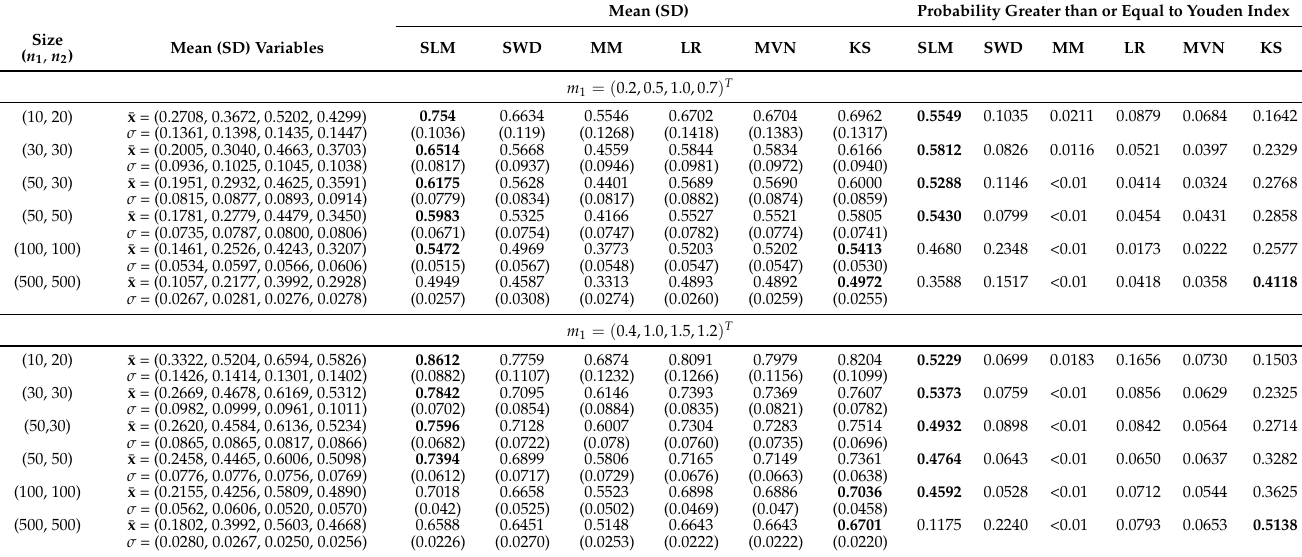
Table 4. Normal distributions: Different means. High correlation ( Σ 1 = Σ 2 = 0.3 · I + 0.7 · J